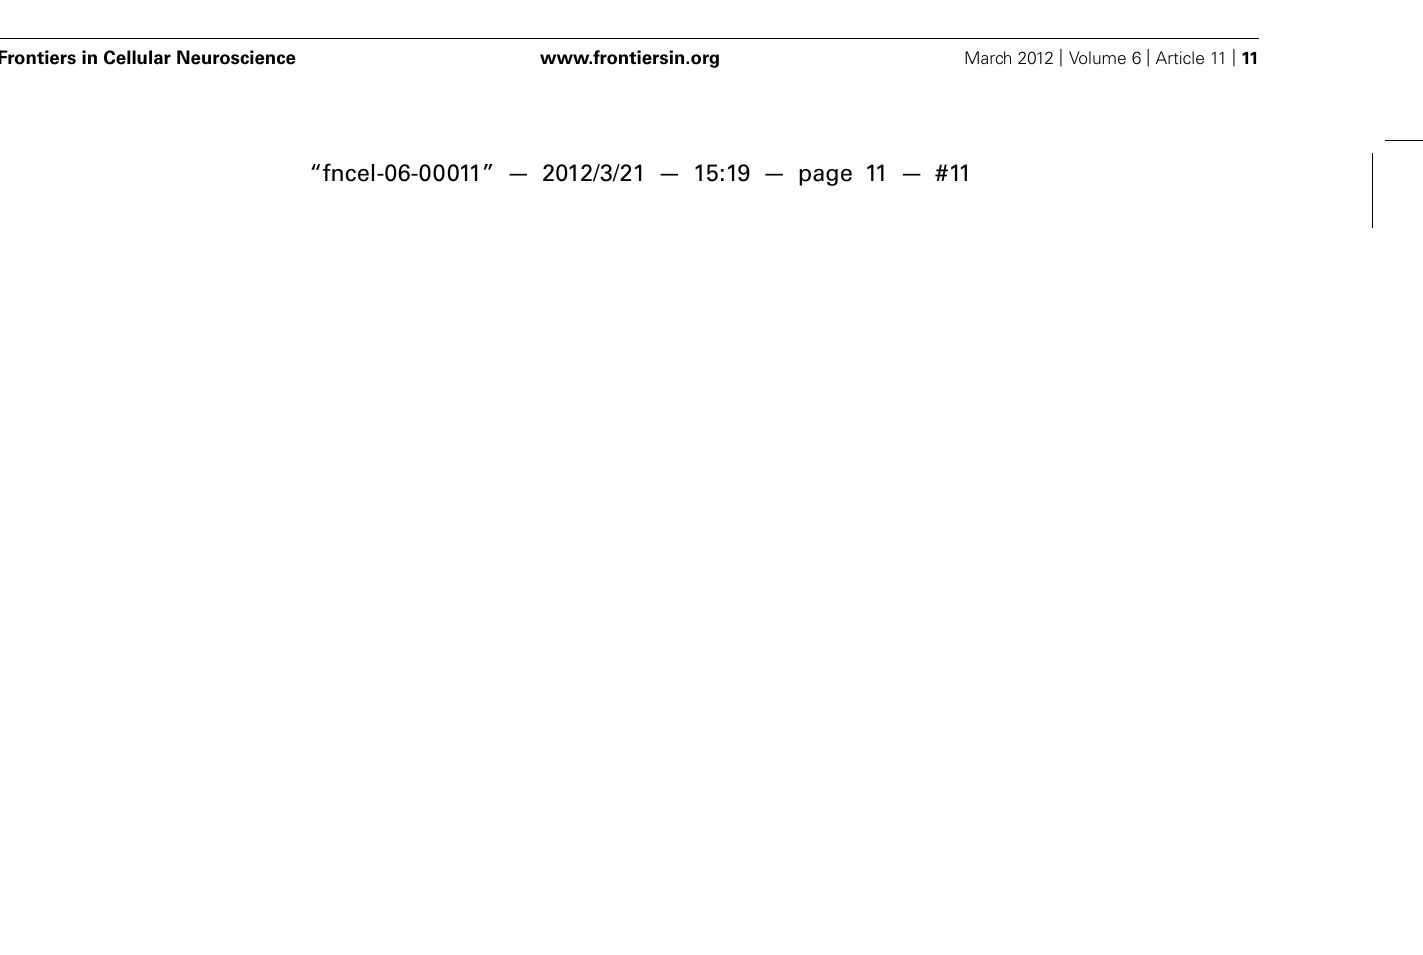
striatum adjacent to the corpus callosum adjacent to numerous host RIP + fiber bundles. (C–E) GFP + fibers closely follow the trajectory of RIP + white matter tracts. (F–H) Many GFP + fibers were also found coursing through the anterior commissure. Scale bar: (A) 200 μ m, (C–H) , 50 μ